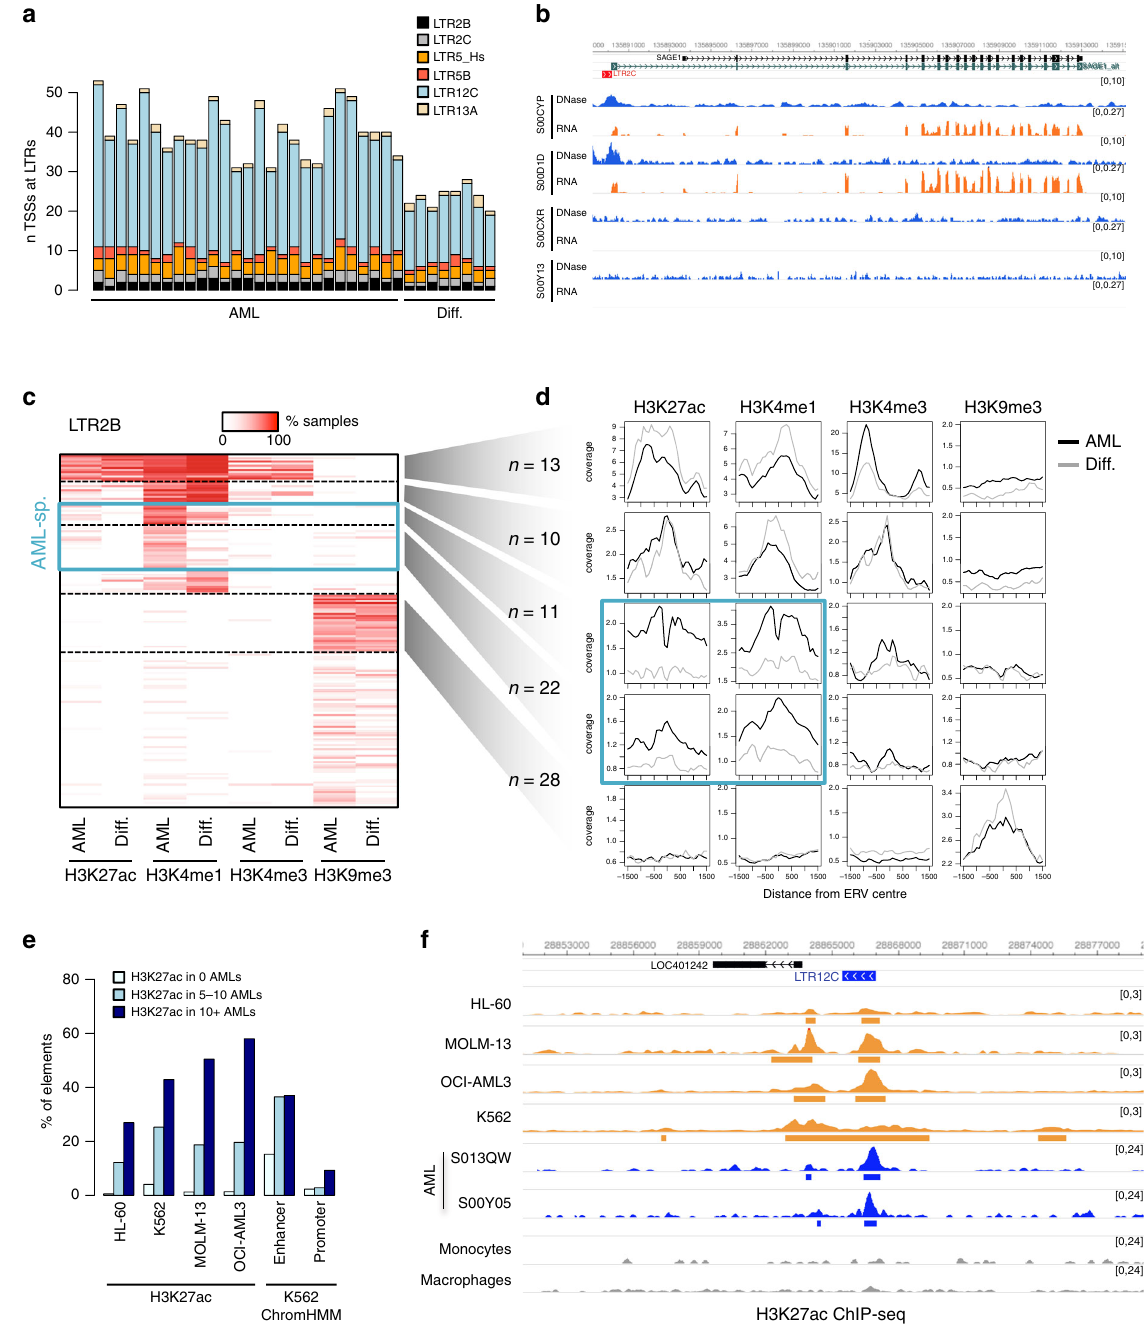
Fig. 2 A-DARs bear signatures of enhancer elements. a Number of transcriptional start sites of spliced transcripts that overlap with A-DAR elements in AML or differentiated myeloid cells. b Example of a LTR12C element that generates an alternative promoter that drives the expression of SAGE1 in AML samples where this element is active. c Heatmap of overlap between LTR2B elements and histone modi fi cation peaks. Colour intensity represents the percentage of AML or differentiated cell samples where overlap is observed. Dashed lines segregate clusters identi fi ed by k-means clustering. d Average ChIP-seq pro fi les for LTR2B elements within speci fi c clusters de fi ned in ( c ). Blue boxes highlight two clusters where H3K4me1 and H3K27ac levels are higher in AML compared with differentiated cells. e Percentage of A-DAR elements that overlap H3K27ac peaks in different cell lines, or that are classi fi ed as enhancers or promoters in ChromHMM data from K562 cells. A-DAR elements were subdivided according to the number of AML samples displaying overlap with H3K27ac. f Example of a LTR13A element where cell lines reproduce the AML-speci fi c H3K27ac marking observed in AML samples. Peaks called by MACS2 are depicted underneath each